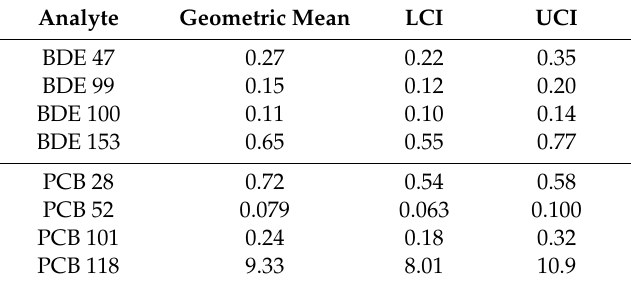
Table 3. Overall level of PBDEs, PCBs, and DDTs in human fat tissue in ng/g of fat and comparison with previous studies for the Czech Republic published in 2009 [39] .